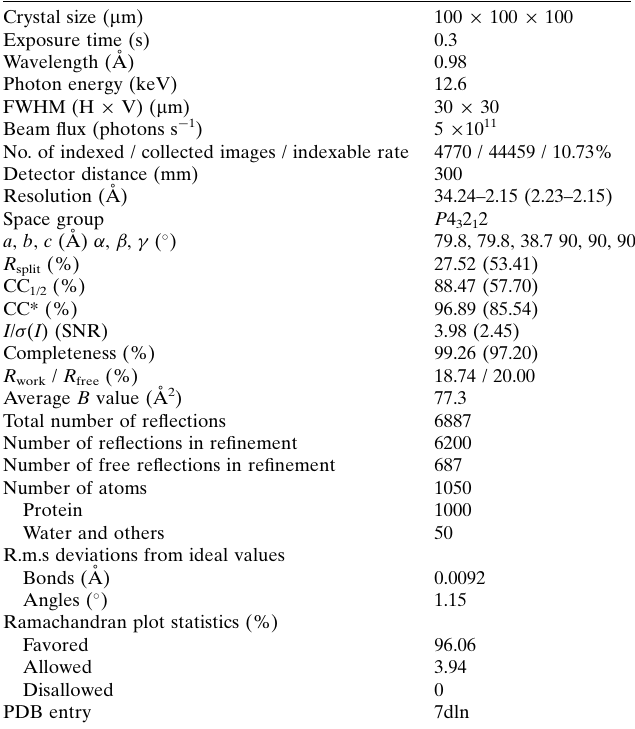
Table 1 Data collection analysis and structural refinement for lysozyme (D1-8). Crystal size ( m